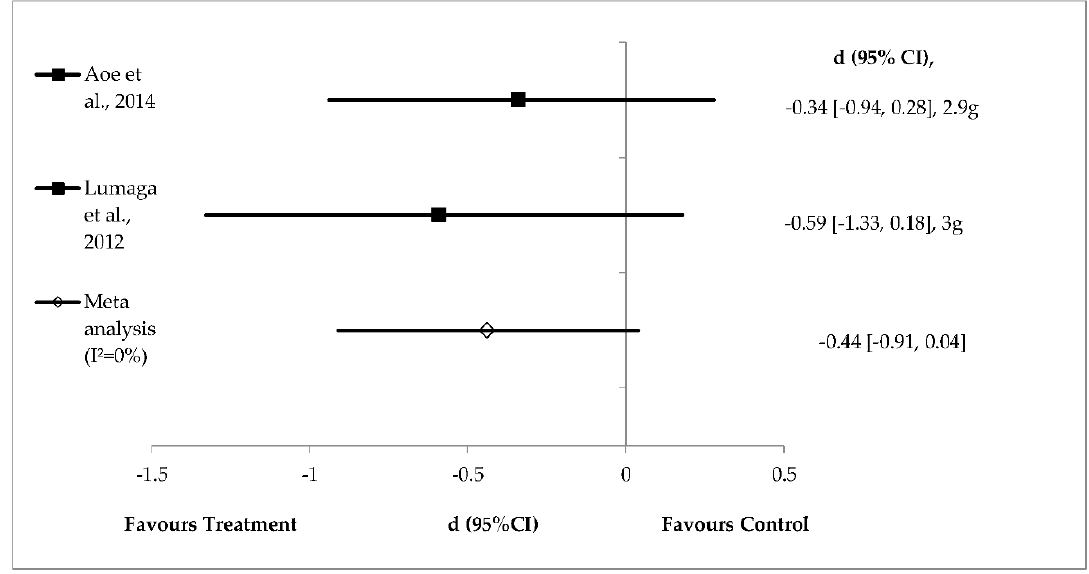
Figure 5. Effects of β -glucan on energy intake reduction (fixed effects model). The axis lines on ±0.2, ±0.5 and ±0.8 represent small, medium and large effect sizes, respectively. A negative value of summary effect size suggests that β -glucan supplementation decreases energy intake compared with control. d = effect size; CI = confidence interval.